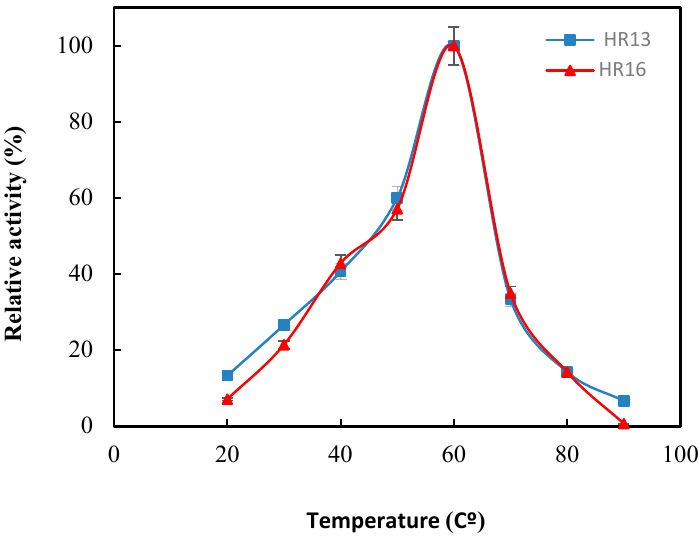
Figure 4. The effect of temperature on the enzyme activity levels of HR13 ( ■ ) and HR16 ( ▲ ) strains; the activity at the optimal temperature was taken as 100%.